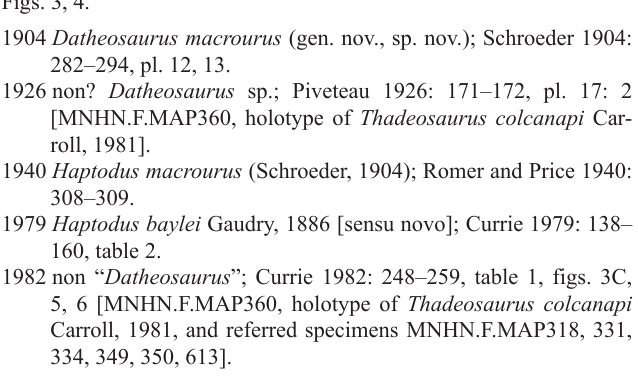
Fig. 3. Holotype of caseasaurian synapsid Datheosaurus macrourus Schroeder, 1904 from Upper Pennsylvanian of Nowa Ruda, Poland. A . MB.R. 1015.1 (laying slab), exposing an internal view onto ventral elements (A 1 ), with close-up of distal-most tail portion (A 2 ). B . MB.R. 1015.2 (hanging slab), expos- ing an internal view onto dorsal elements (B 1 ), detail (B 2 ), trough stratification of the area indicated by the arrowhead in B 1 .